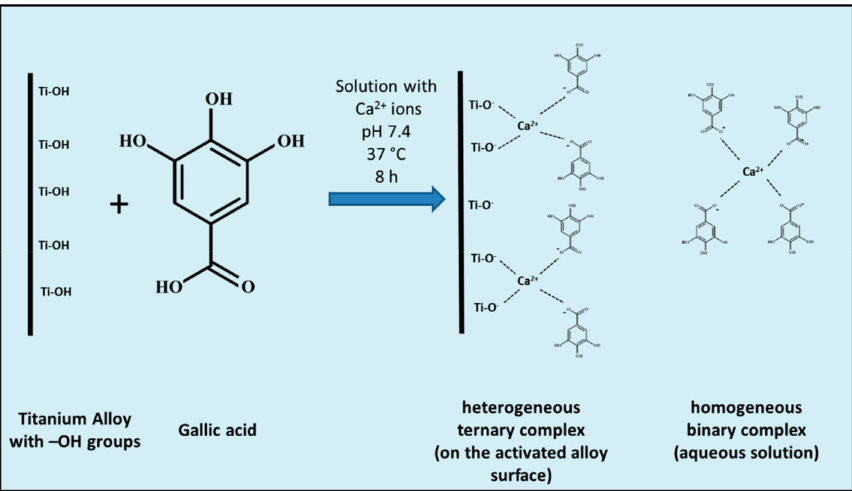
Figure 2. Scheme of the possible binding of gallic acid with the titanium alloy surface and Ca (II). Only the planar coordination is